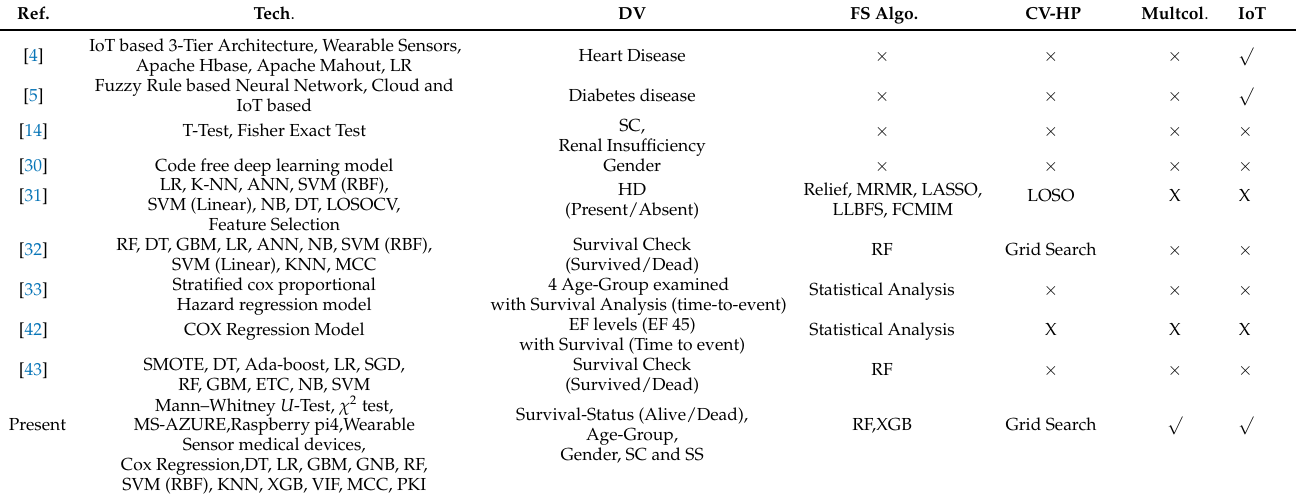
Table 1. Previous research versus Extant